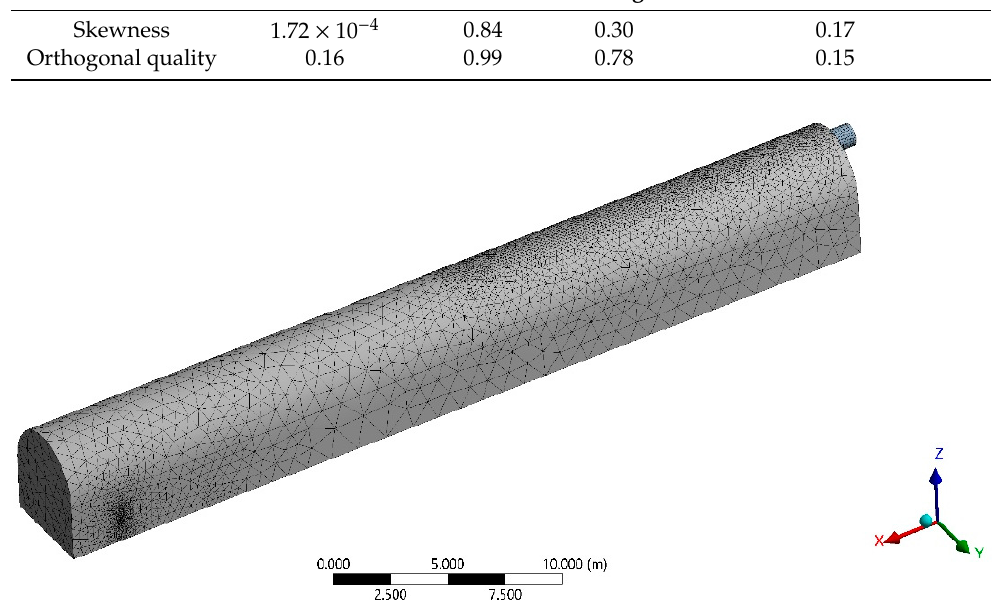
Figure 8. The original computational mesh.